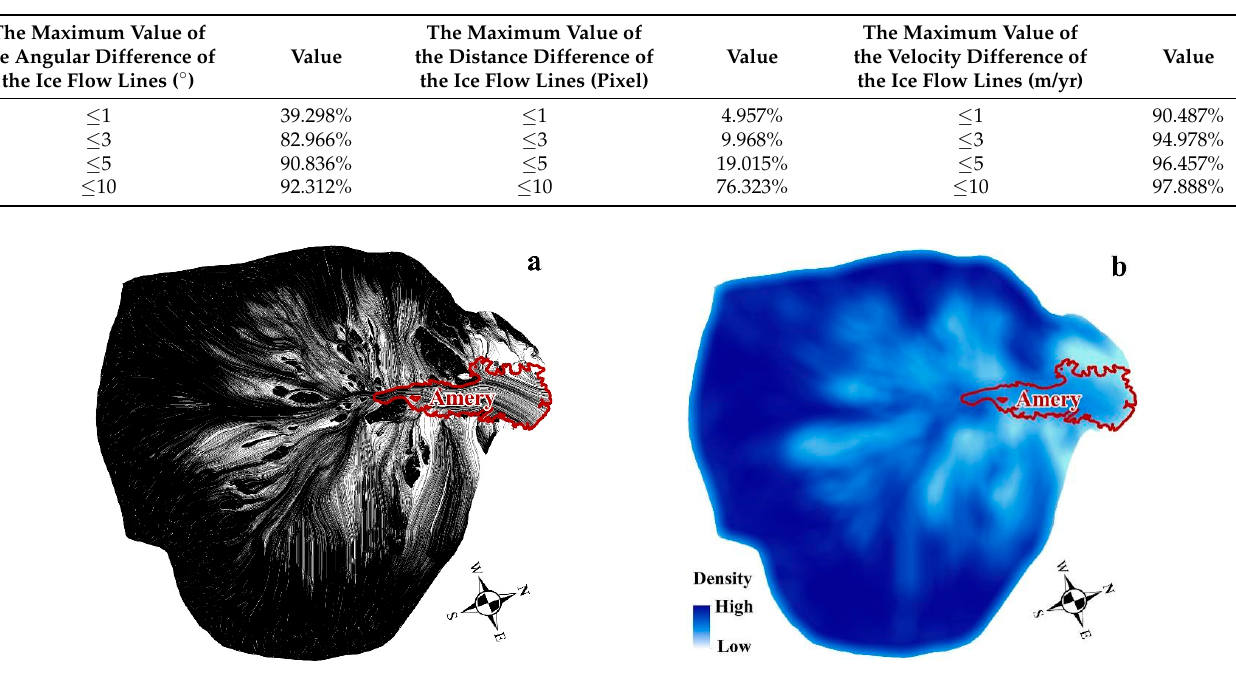
Figure 7. Ice flow lines and its density of B-C basin and its fringing Amery ice shelf (no thinning of ice flow lines). ( a ) Ice flow lines. ( b ) Density of ice flow lines.